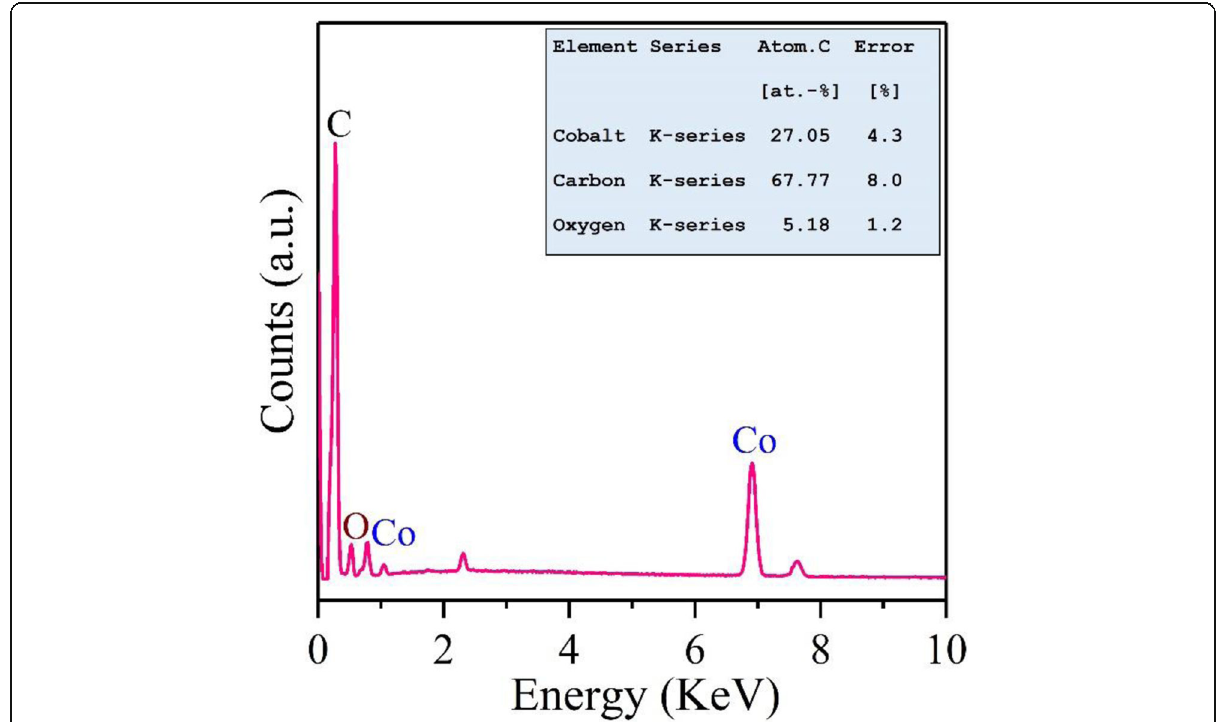
Fig. 3 EDX spectrum of Co-rGO nanohybrid. The inset image shows obtained elemental mapping results of Co-rGO